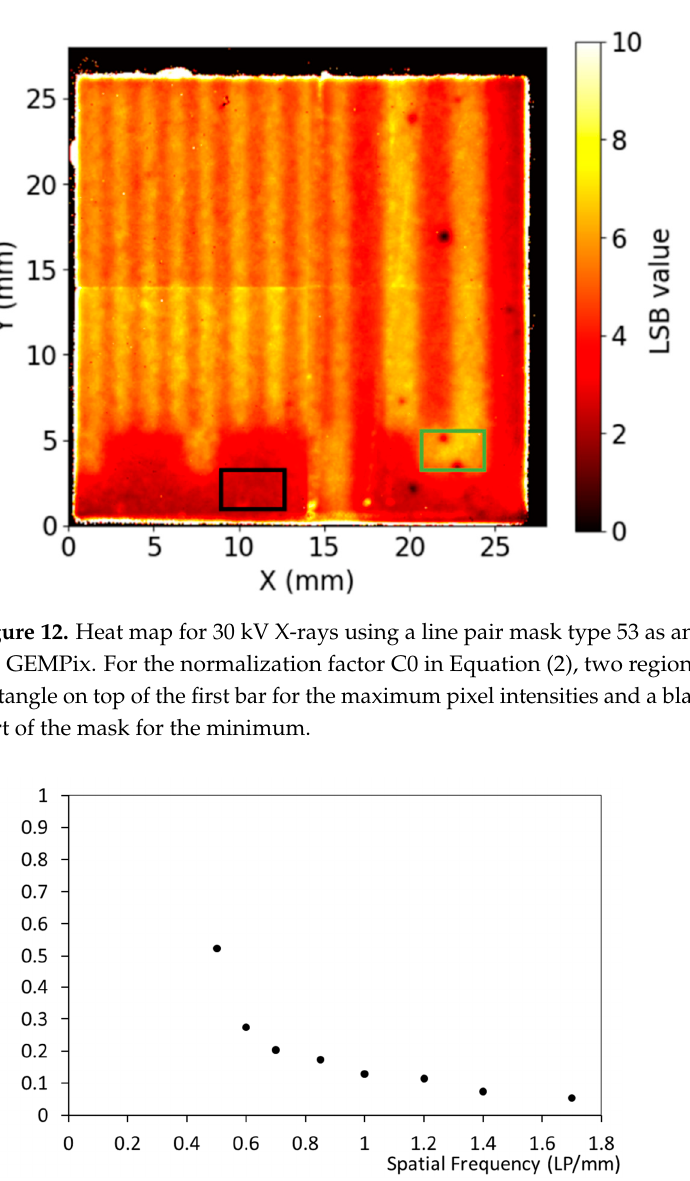
Table 1. Calculated FWHM of the 1D profiles for three regions of interest of the images obtained by the GEMPix and the 1 mm-thick copper plate.